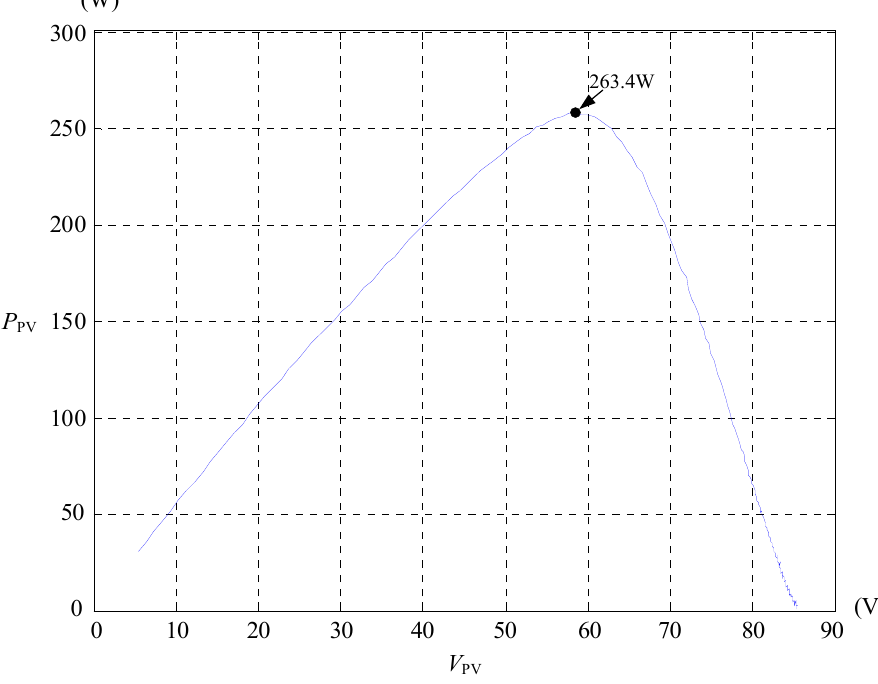
Figure 6. A single experimental P–V characteristic curve for all optimized configurations in Case 2. Note that 1 and 0 represent the ON and OFF states of a switch, respectively, and the switches with an always ON state in each case are highlighted. The position of each switch is indicated in Figure 1. 5.1.3. Case 3: A 30% Shaded PV Module in Row 3 (Module 3, 7, or 11) The same test as in Cases 1 and 2 is repeated on the case of a single 30% shaded module on the third row. The optimized array configurations are presented in Table 2, but not illustrated for brevity. The highlighted portions in gree indicate that the output power is optimized on a condition that switches S 2 , S 3 , S 7 , and S 8 are switched on. The same P–V characteristic curve as in Figure 5 is seen again in Figure 7 for this case. The peak power plunges from 334 W in an unshaded case to 266.4 W in this